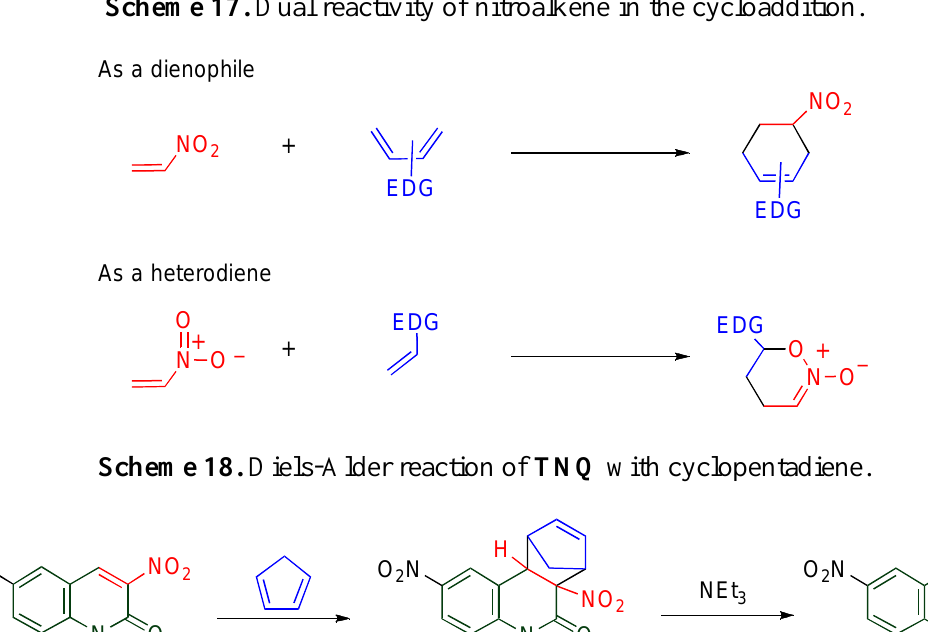
Scheme 17. Dual reactivity of nitroalkene in the cycloaddition.